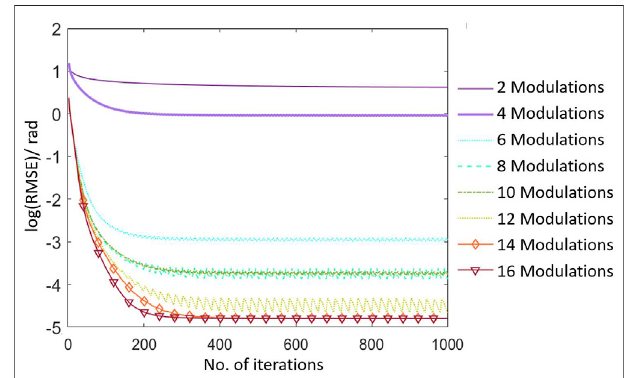
FIGURE 4 | The logarithm of the RMSE of the ASPM method using 2 to 16 modulations.